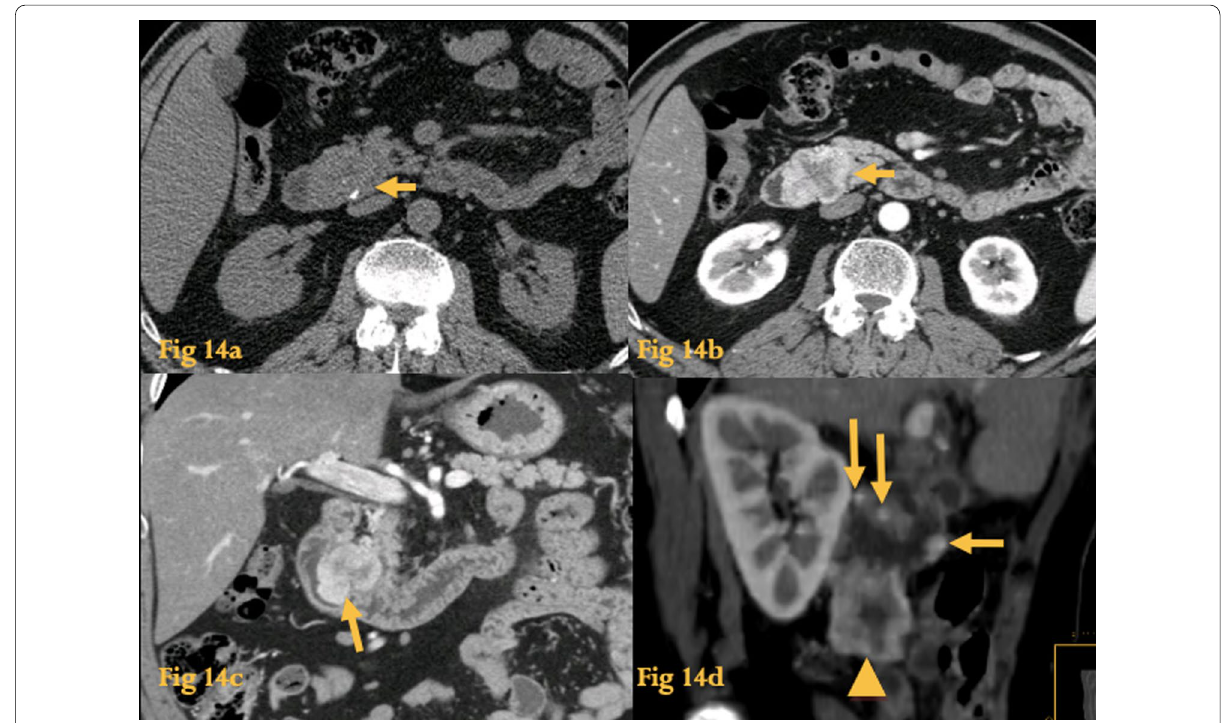
Fig. 14 GIST. Unenhanced abdominal CT ( a ) shows a heterogeneous soft‑tissue lesion with punctiform calcifications on the horizontal portion of the duodenum (arrow). Abdominal CT after iv contrast ( b ) shows peripheral enhancement and central necrosis (arrows). Coronal reformation of the same patient ( c ) better depicts the origin of the lesion (arrow) from the duodenal wall and the endophytic component. Histopathological study revealed a duodenal malignant GIST with pancreatic invasion, central necrosis, and small calcifications. Abdominal CT ( d ) of another large malignant GIST with exophytic growth pattern (arrowhead), which also shows several other small enhancing parietal metastases, in D2